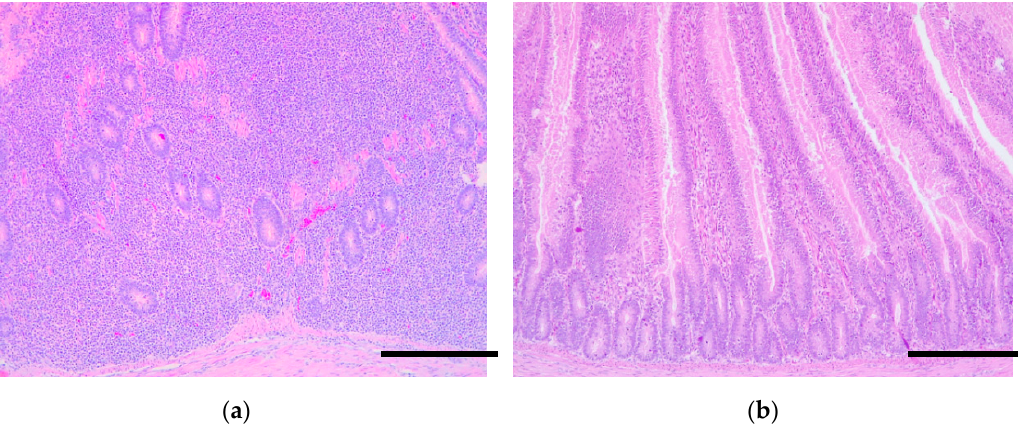
Figure 3. Histopathological study of the duodenum of 14-day-old broilers, 7 days post-infection with Salmonella Typhimurium. ( a ) Control group. There is a severe lymphocytic inflammatory infiltrate that completely distorted the crypt structure. There are scattered haemorrhagic foci. ( b ) Treated group. The lamina propria is mildly expanded by a lymphocytic inflammatory infiltrate with a few heterophils. 20×, scale bar: 250 μ m.